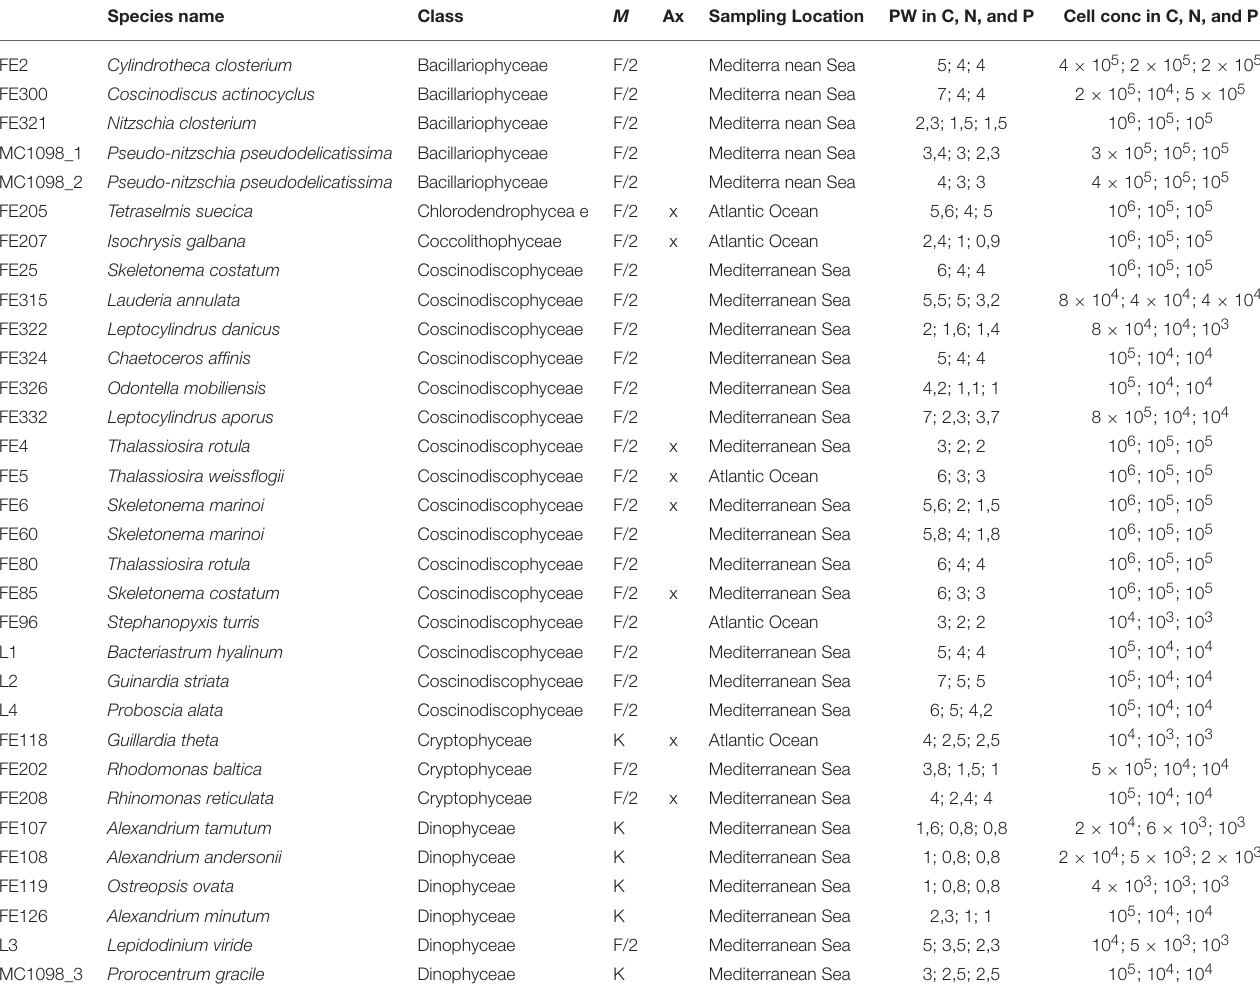
TABLE 1 | The table reports the culture collection code, species name, and class, medium (M) used for culturing, axenicity (Ax) information, and sampling location for each microalgae selected for this study. In addition, it reports the approximate pellet weight (PW) and cell concentration used for the chemical extractions of microalgae cultured in control, nitrogen- and phosphate-starvation (C, N, and P,